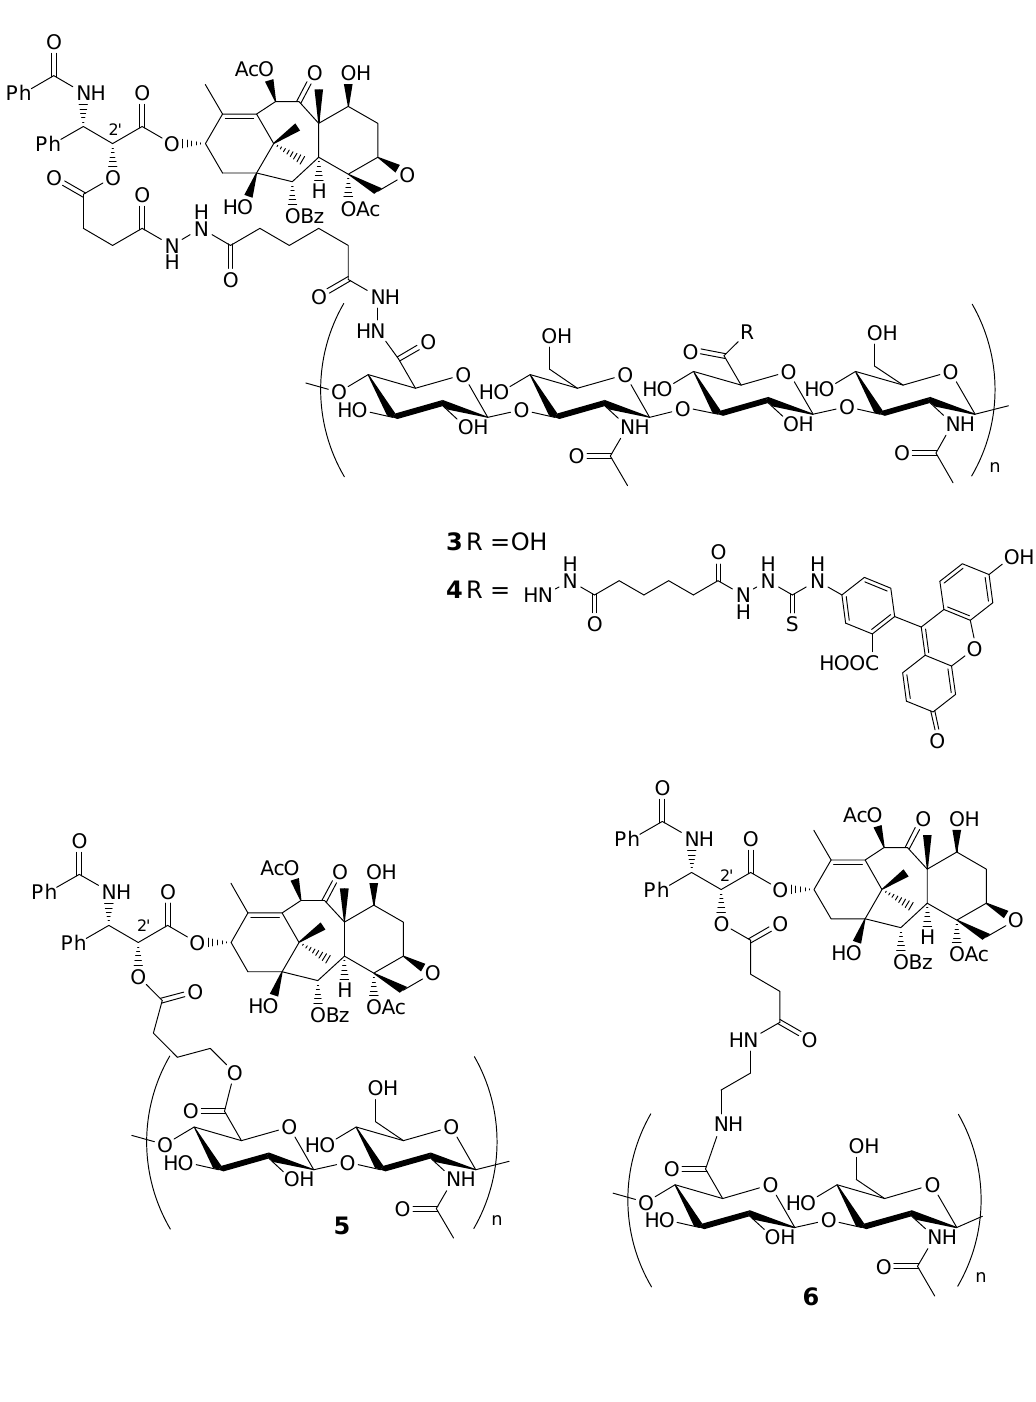
Figure 1. HA-paclitaxel Bioconjugates